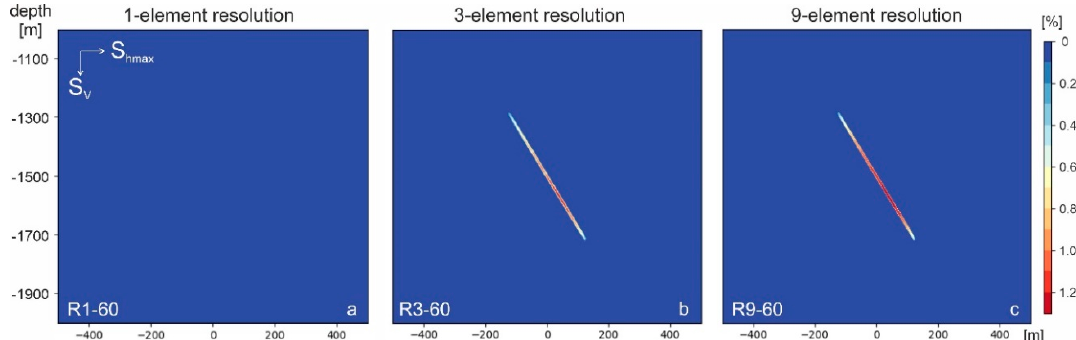
Figure 9. Spatial variations in the von Mises plastic strain after the last load step for 1-element- ( a ), 3-element- ( b ) and 9-element- ( c ) wide fault zones dipping at 60° and using a rectangular grid.